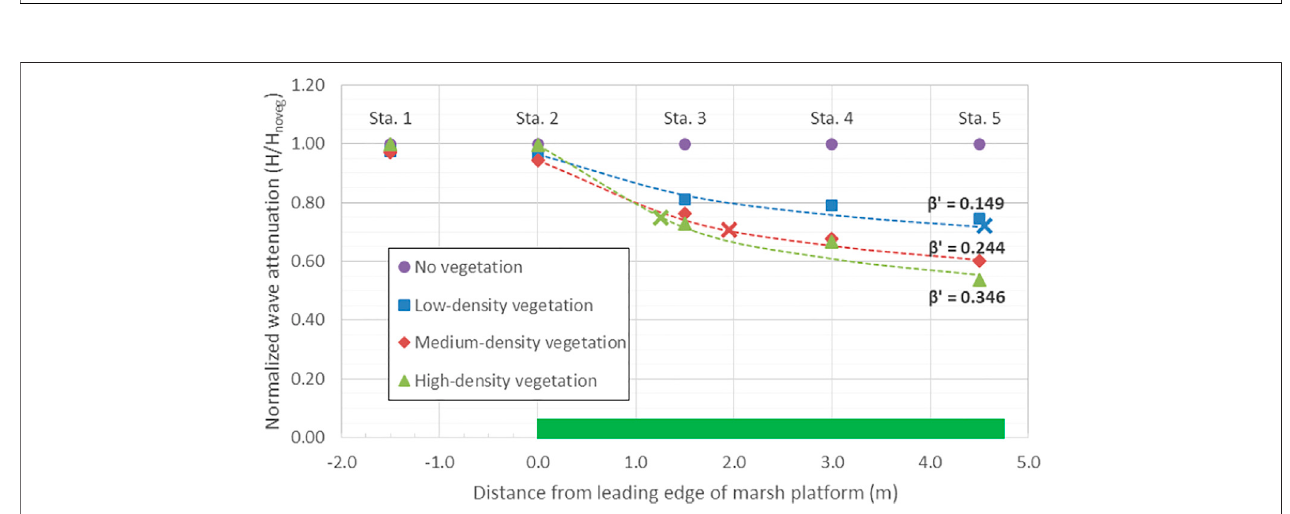
FIGURE7| Waveattenuationacrossthearti fi cialmarshfordifferentvegetationdensities.Dataisnormalizedbythecasewithnovegetationtoremovetheeffectsof wavetransformation and breakingdue tothe sloping foreshore and shallowdepths, and highlightthe role ofvegetation in wave attenuation. Datapoints denote average measurements across a wide range of wave heights, periods, and water depths. Dashed lines denote predicted ( fi tted) curves and corresponding β ′ values. The bold X denotes the distance from the leading edge ofthe model vegetation canopy encompassing 700surrogate stems for each vegetation density. Refer to Figure 2 for the location of the measurement